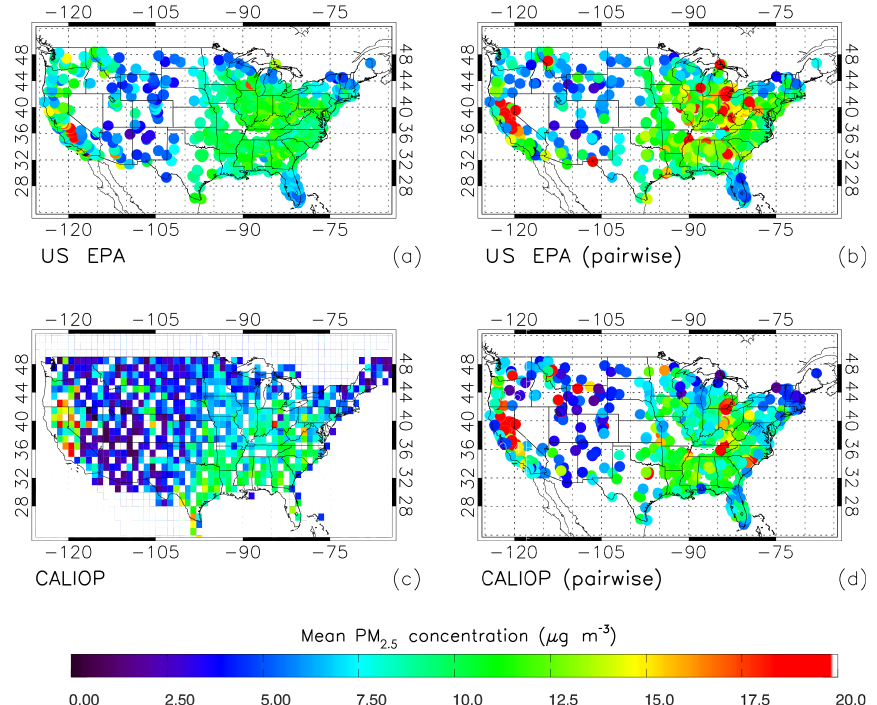
Figure 2. For 2008–2009 over the CONUS, (a) mean PM 2 . 5 concentration (µgm − 3 ) for those U.S. EPA stations with reported daily mea- surements, and (c) 1 ◦ × 1 ◦ average CALIOP-derived PM 2 . 5 concentrations for the 100–1000ma.g.l. atmospheric layer, using Eq. (3), for combined daytime and nighttime conditions. Also shown are the pairwise PM 2 . 5 concentrations from (b) EPA daily measurements and (d) those derived from CALIOP (day and night combined), both averaged for each EPA station for the 2008–2009 period. For all four plots, values greater than 20µgm − 3 are colored